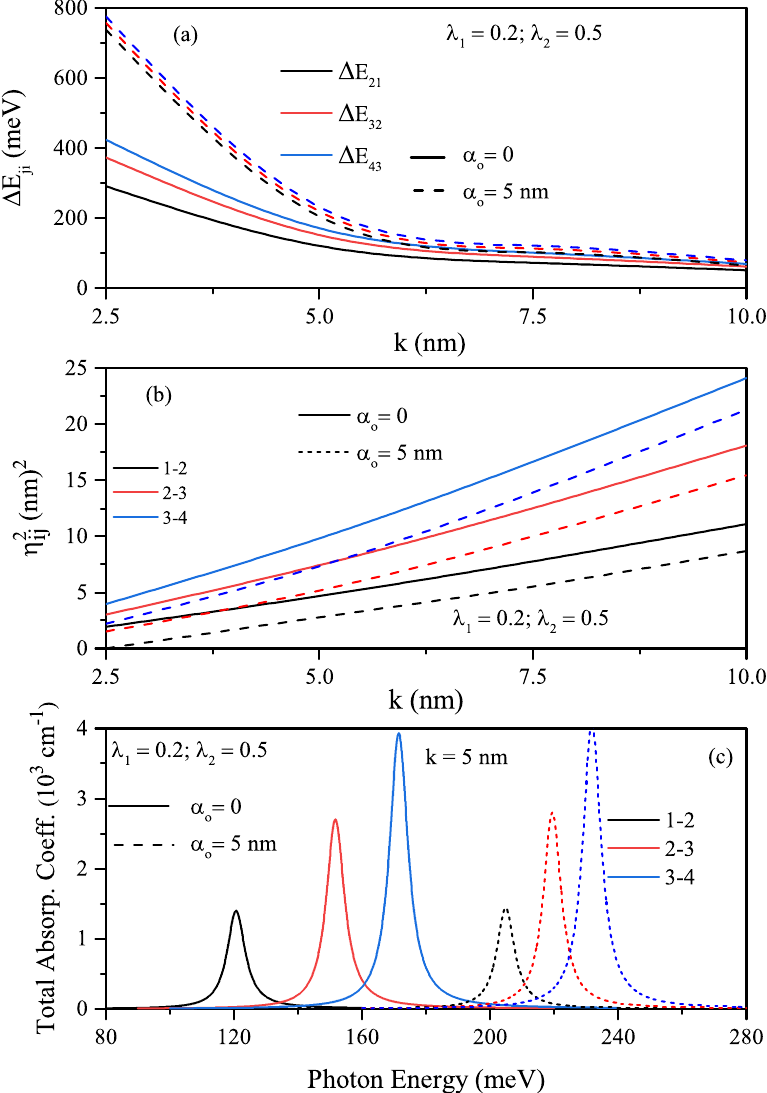
Figure 5. The energy difference between two indicated levels of the electron confined in the quartic single AHO versus the k -parameter ( a ), the squared reduced transition matrix elements corresponding to the relevant levels versus the k -parameter ( b ), and the variation of total absorption peaks as a function of the incident photon energy for k = 5 nm ( c ). The results are for λ 1 = 0.2, λ 2 = 0.5, α 0 = 0 (solid lines) and α 0 = 5 nm (dashed